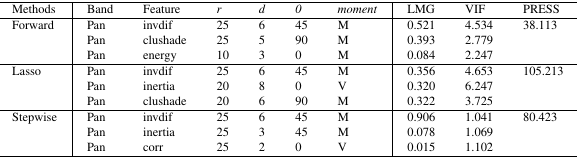
Table 4: Comparison of subset selection methods in retrieving ages from panchromatic data ( n = 12 ) The LARS stepwise selection was then applied in a multi-scale approach, combining Pan and MS datasets, in order to find